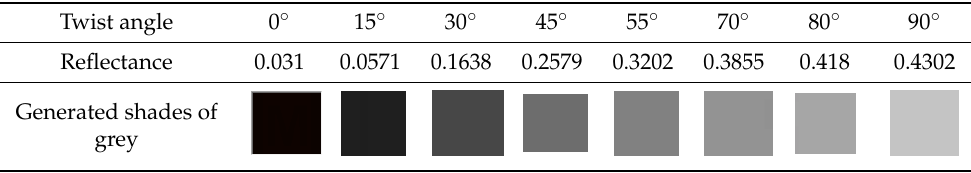
Table 1. Computer-generated grey tones for different twist angles.